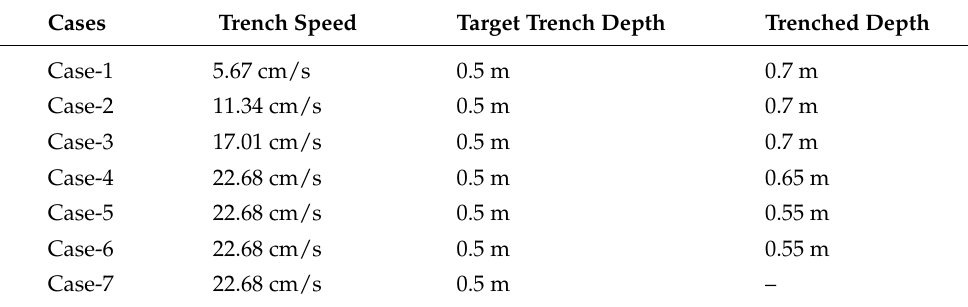
Table 6. Ground field test